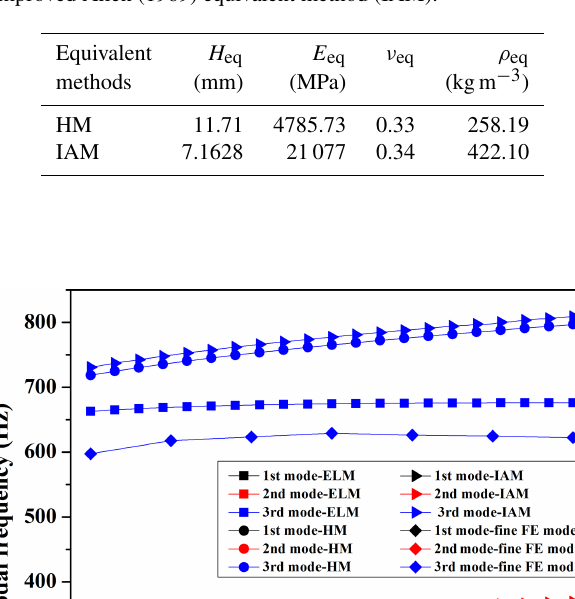
Table 5. Equivalent material parameters of the single-layer plate equivalent method based on the Hoff (1948) theory (HM) and the improved Allen (1969) equivalent method (IAM).